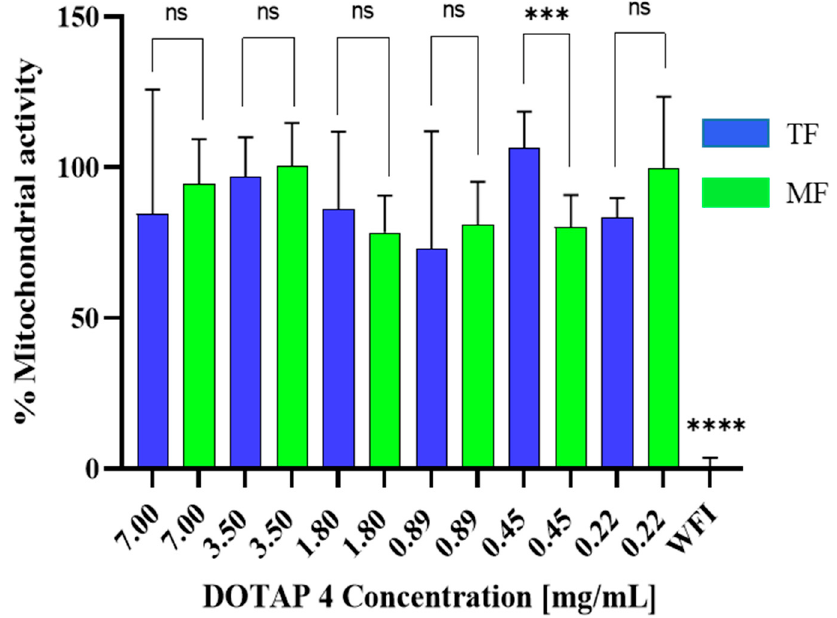
Figure 3. Toxicity of different concentrations of blank DOTAP 4 liposomes manufactured by microfluidics (MF) and thin-film (TF) rehydration method liposomes on RAW 264.7 cells, incubated on cells for 4 h. Data were normalized to non-treated cell results. WFI served as positive control. Data are represented as mean ± SD ( N = 3). **** indicates p < 0.0001, *** p < 0.001, ns shows non-significance. All samples have a significant difference at p < 0.0001 with WFI control.